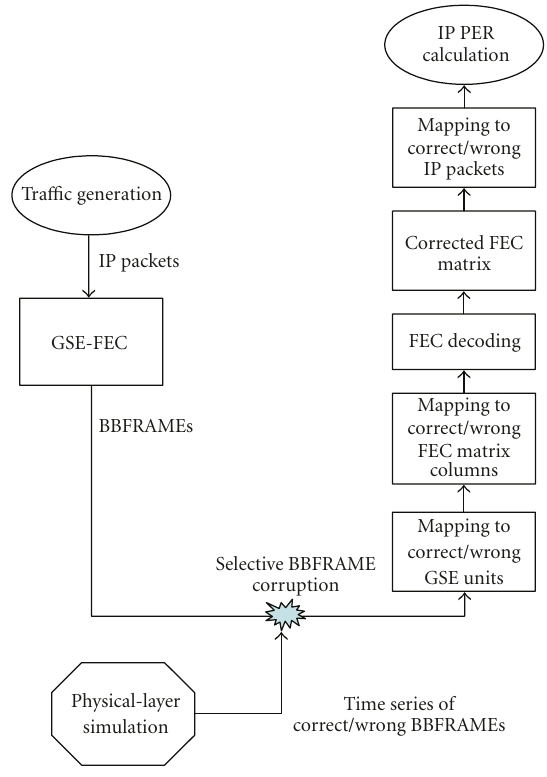
Figure 9: Simulation platform at IP-BBFRAME level.